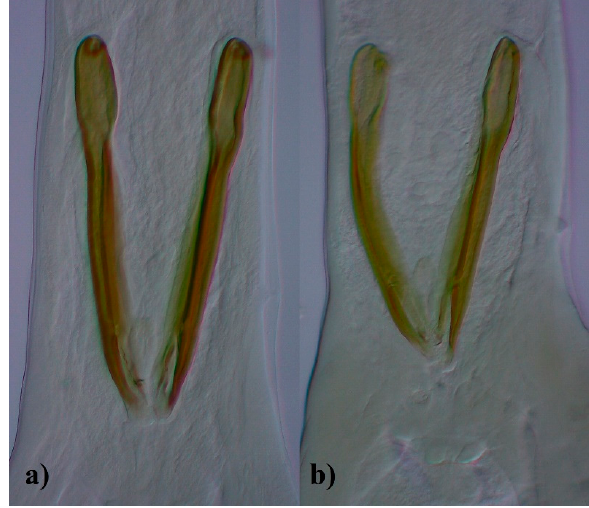
Figure 2. Spicules of Ostertagia leptospicularis from ( a ) roe deer ( Capreolus capreolus ), ( b ) cattle ( Bos taurus ) ventral view (magnification 400×).